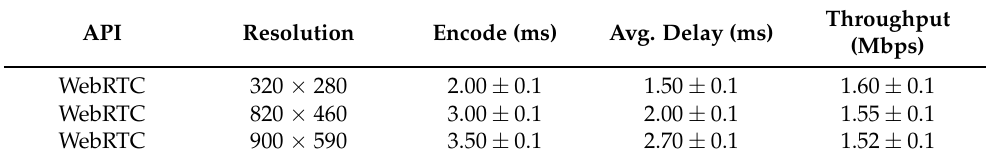
Table 2. Performance evaluation of